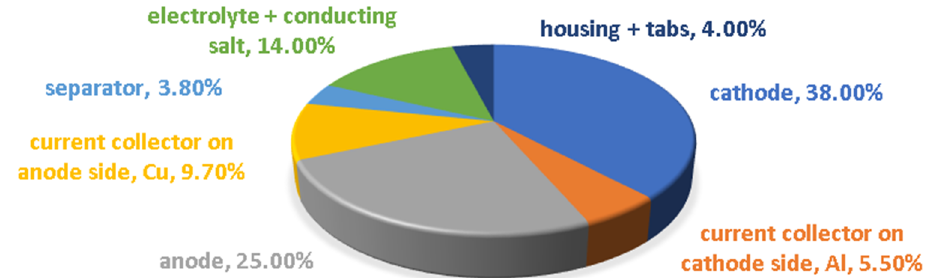
Figure 2. Estimated mass split of the investigated fresh automotive pouch cell in discharged condition.